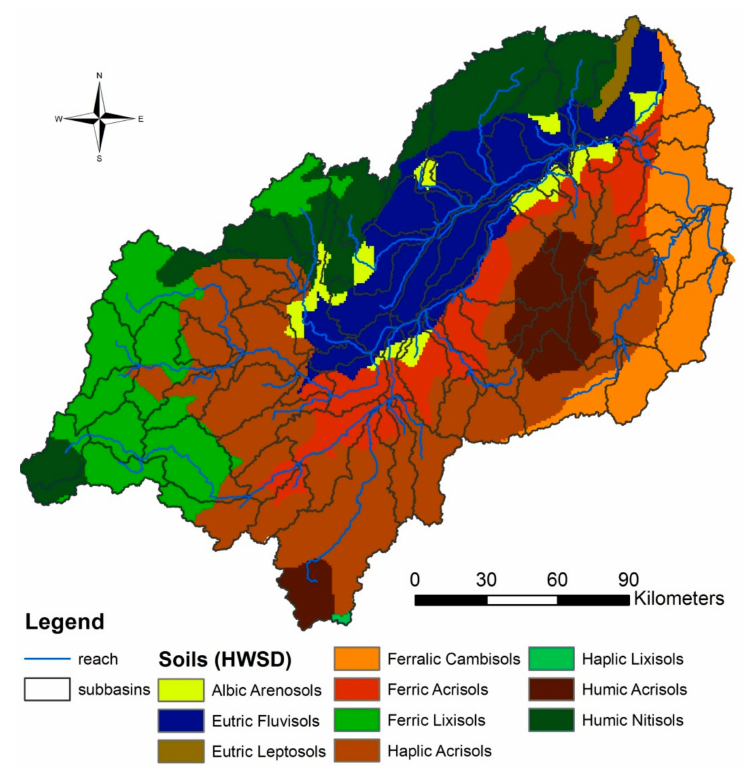
Figure 2. Distribution of soils for the Kilombero Catchment, according to the Harmonized World Soil Database